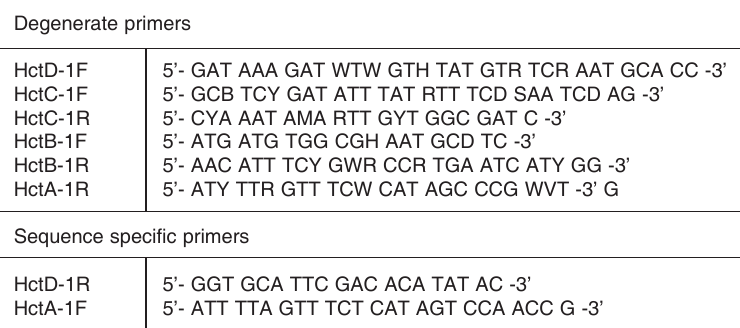
TABLE 1 Degenerate and sequence specific oligonucleotides used for the amplifi- cation of the capsule transport gene locus from H. paragallinarum Degenerate